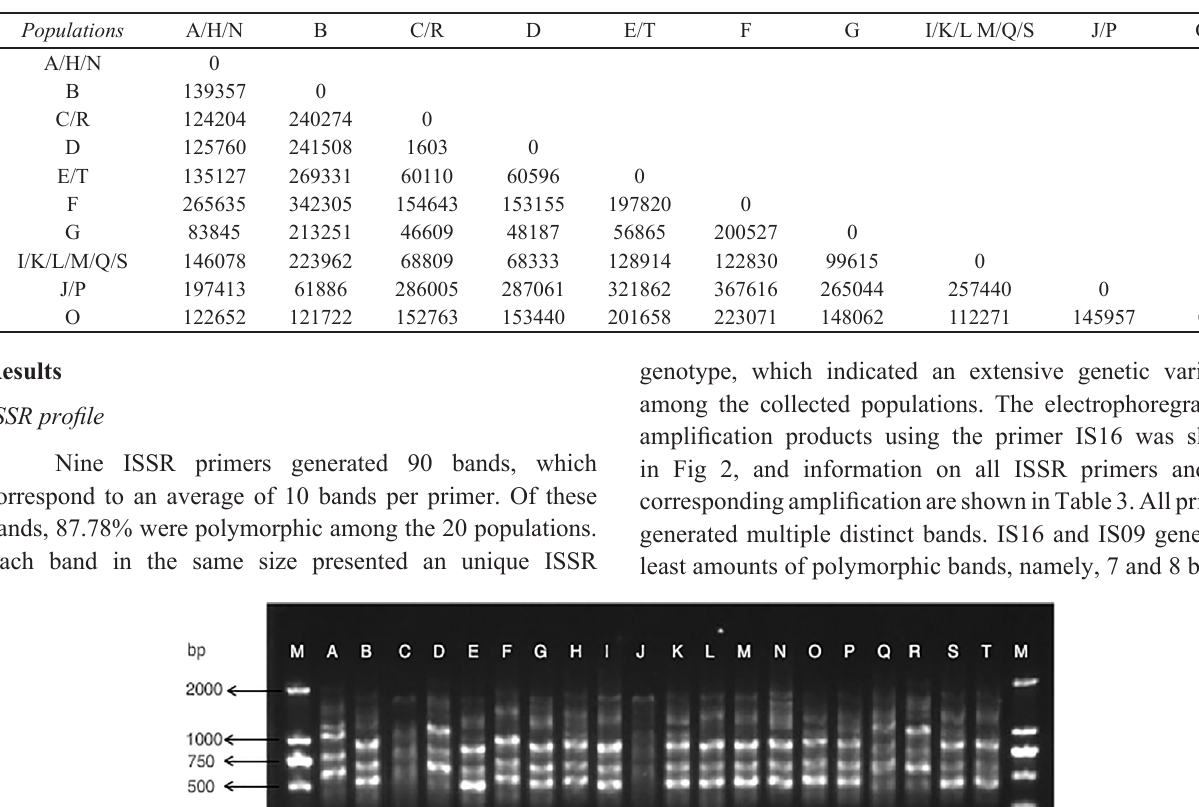
Table 2 . Geographical distance among all populations. (unit: m)